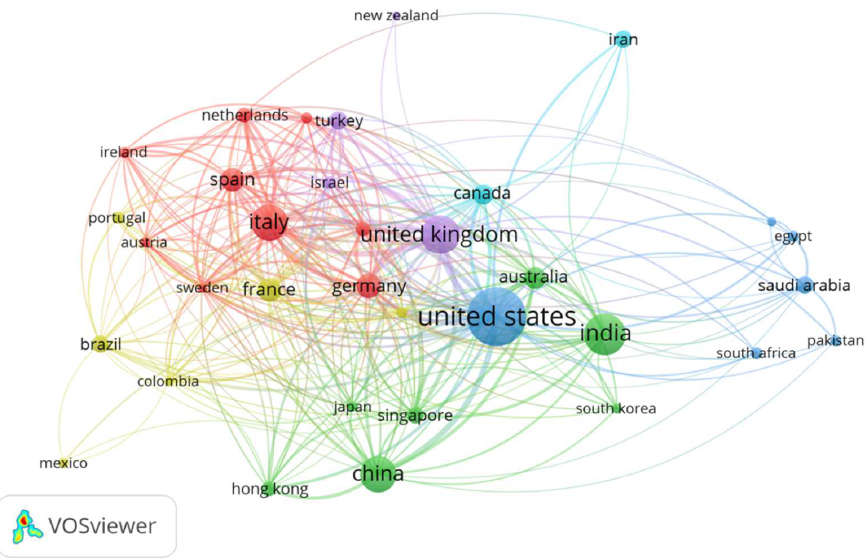
Figure 2. Network visualization map of international collaboration among countries with a minimum productivity of 15 documents. The thickness of the connecting line between two countries shows the strength of collaboration. Countries with a similar color form one cluster. For example, the countries in red, such as Germany, Spain and Italy, are found in one cluster with the highest collaboration in this cluster. Table 3. Top 10 active journals in publishing in eye-related COVID-19 literature (2019–2021) N = 2206. Source